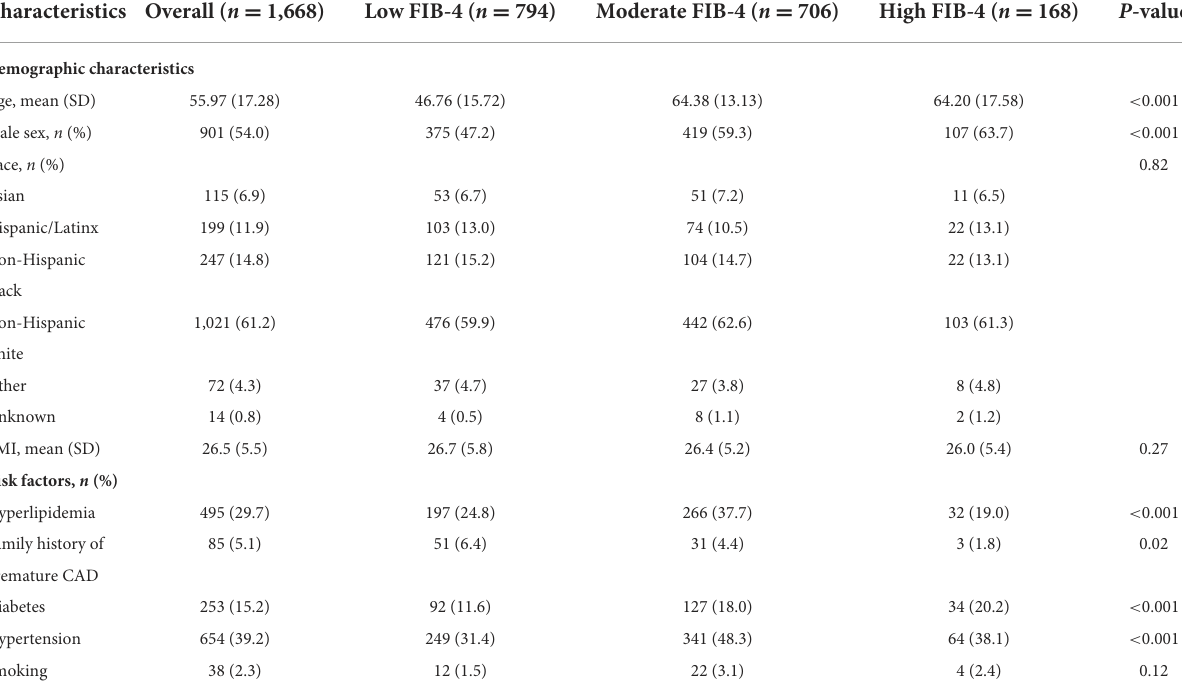
TABLE 2 Demographic and clinical